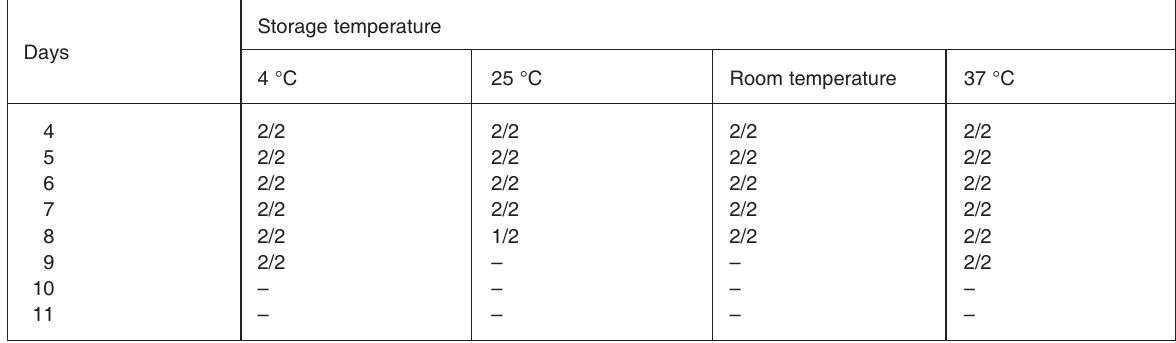
TABLE 3 Results obtained when commercially available Amies Transport swabs without charcoal (A/Ts) was used to store H. para- gallinarum at different